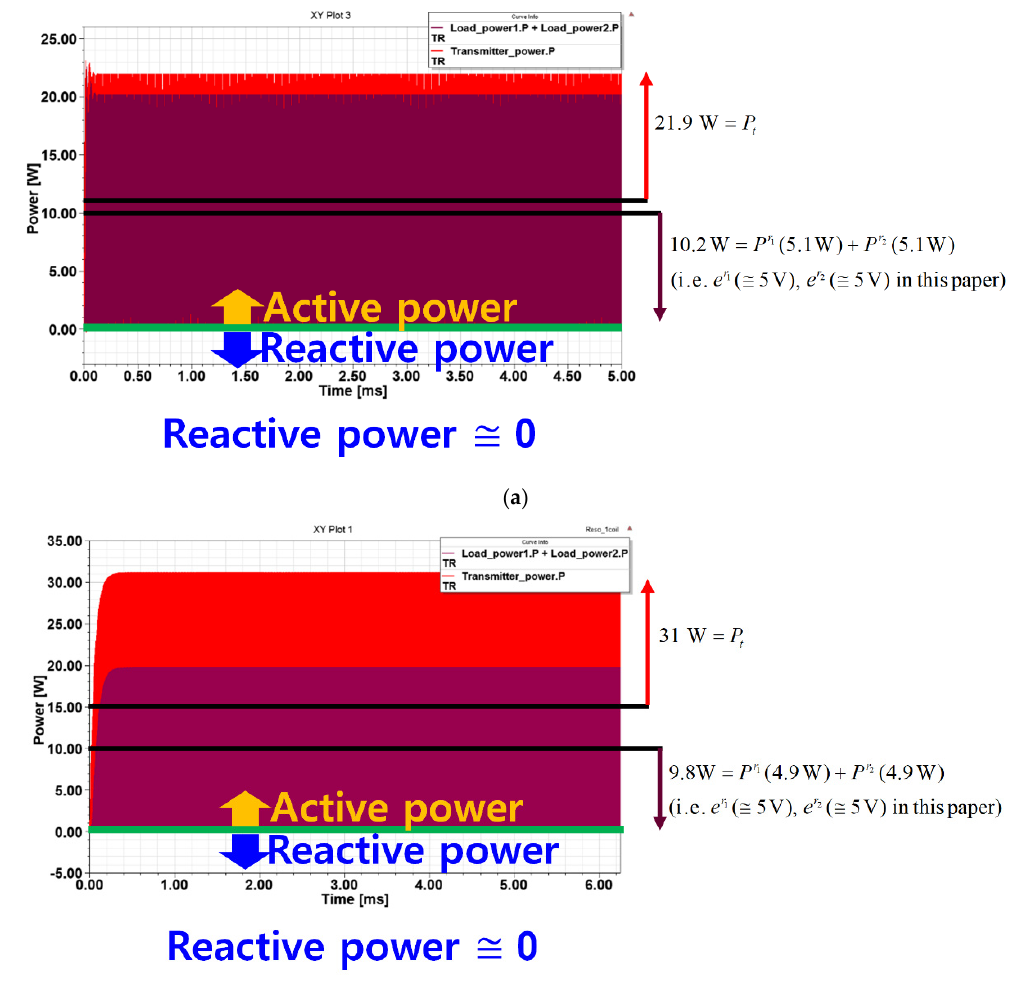
Figure A2. Optimized history for setting resonance for the S-M WPT systems with the air gap of 10 mm and 30 mm. ( a ) Air gap of 10 mm; ( b ) Air gap of 30 mm.